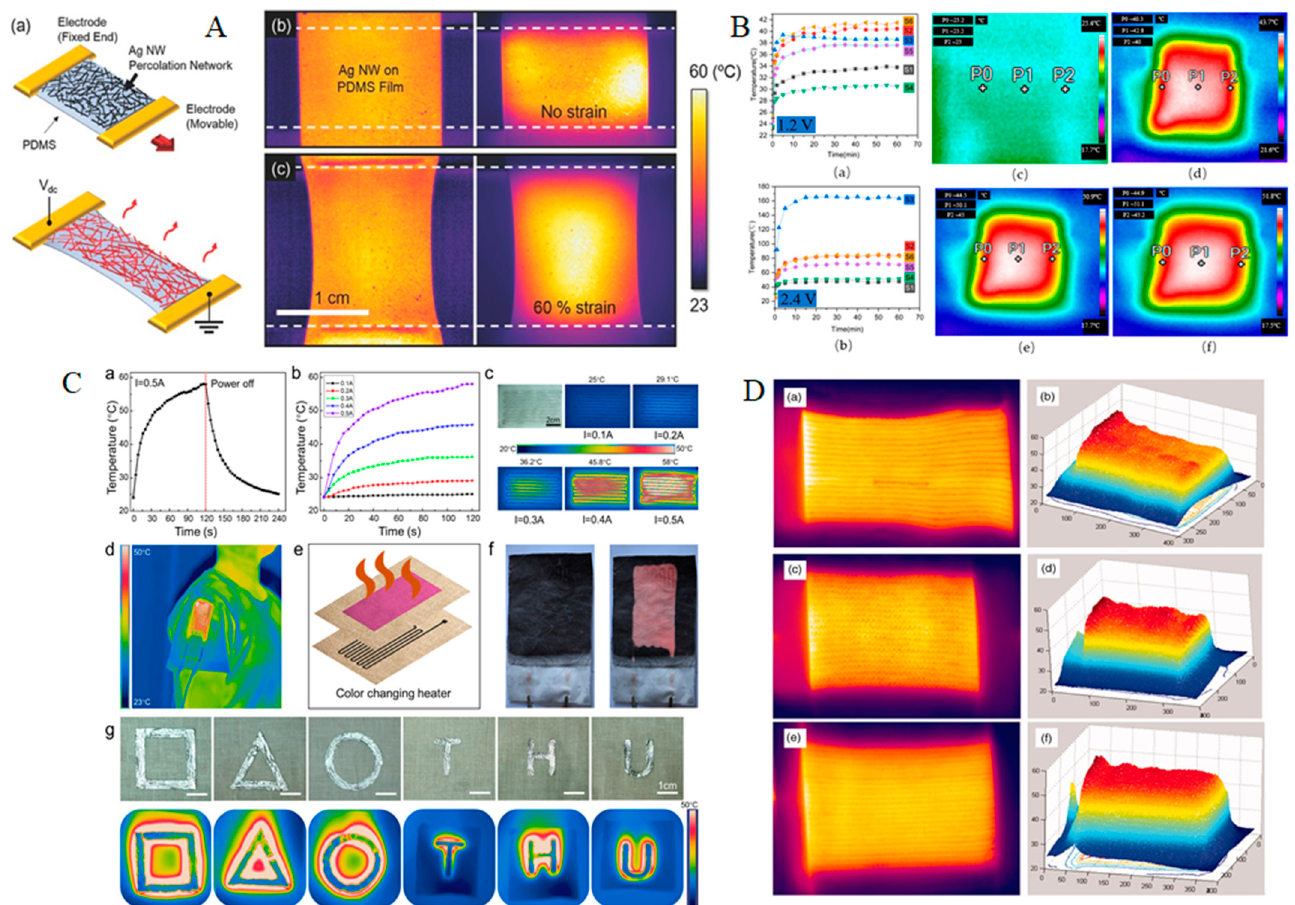
Figure 4. ( A ) Highly stretchable and transparent heater. ( a ) Schematic illustration of the stretchable and transparent heater composed of AgNW percolation network on PDMS film; ( b , c ) pseudocolor image at room temperature (left) and infrared camera thermal image (right) of a Ag NW/PDMS stretchable and transparent heater operating at 60 °C with ( b ) no strain and ( c ) at 60% strain condition [79]; ( B ) sample temperature change with time of S1–S6 under ( a ) 1.2 V and ( b ) 2.4 V and thermal images of S4 ( c ) before and ( d ) after 1 min, ( e ) after 30 min, and ( f ) after 1 h of application of a voltage of 2.4 V [78]; ( C ) thermal management device printed on woven cotton fabrics. ( a ) Temperature curve of the serpentine Cu-EGaIn conductors during heating/cooling process under input current of 0.5 A. ( b ) Temperature curve of the serpentine Cu-EGaIn conductors during the heating process under various input currents. ( c ) Picture of the thermal management device and its infrared temperature distribution images at 120 s under various input currents. ( d ) Infrared temperature distribution image of the thermal management device sewn on a T-shirt. ( e ) Structure diagram of the woven cotton fabric with color changing pigment. ( f ) Thermochromic display of the serpentine Cu-EGaIn conductors. ( g ) Infrared temperature distribution image of multiple Cu-EGaIn patterns heated by the electromagnetic heating coil [80]; ( D ) infrared images of ( a ) PSF, ( c ) RSF and ( e ) ILK and three-dimensional images of ( b ) PSF, ( d ) RSF and ( f ) ILK at 4 V [76]. Table 3. Summary of metal-coated heating textile.